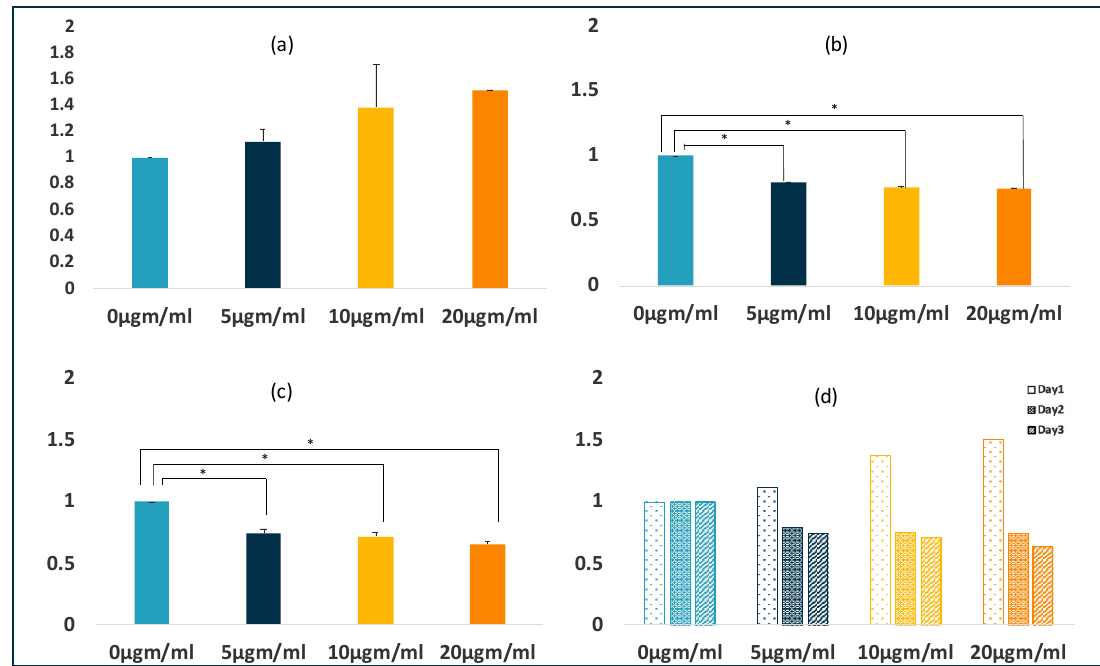
Figure 1. Effects of LPS on proliferation of PDLSCs in 2D culture. LPS inhibited the proliferation of PDLSCs. The graphs depicts the PDLSC’s proliferation after 24 ( a ), 48 ( b ), and 72 ( c ) hours of LPS treatment. Graph ( d ) represents the mean proliferation values of the PDSLC’s after 24, 48, and 72 h of LPS treatment. The values of three independent experiments are presented as means ± SD. * p ≤ 0.05 .